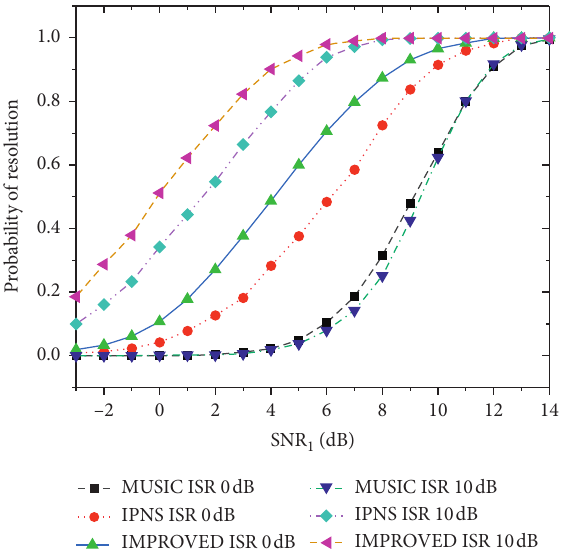
Figure 8: The probability of resolution against SNR